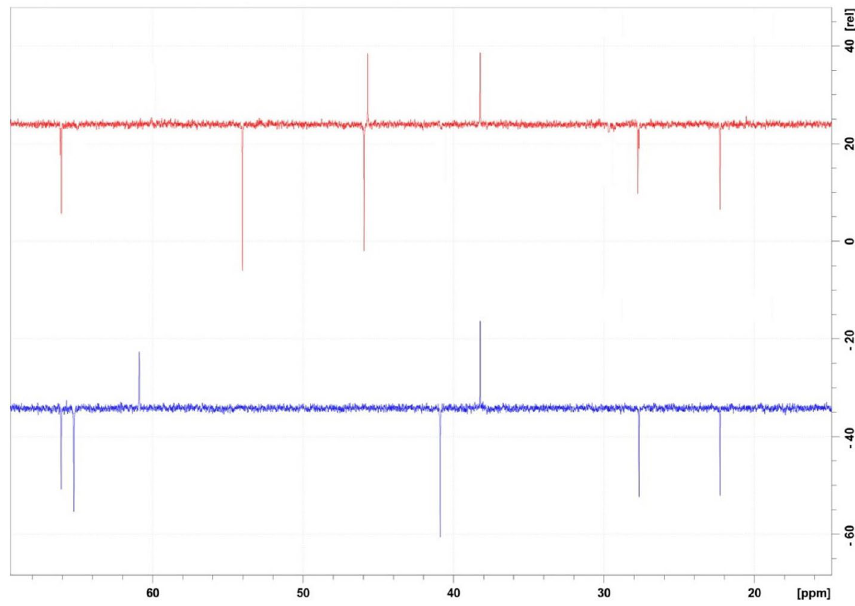
Figure 6. DEPT 135 major differences between Sildenafil (Upper Red) and Sildenafil N-oxide (lower Blue).